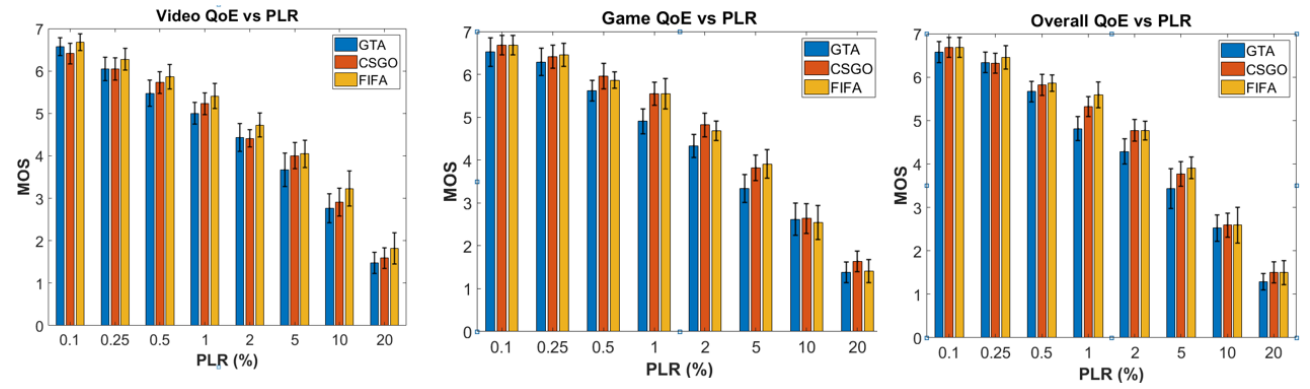
Figure 7. Different QoE dimensions against PLR-only of